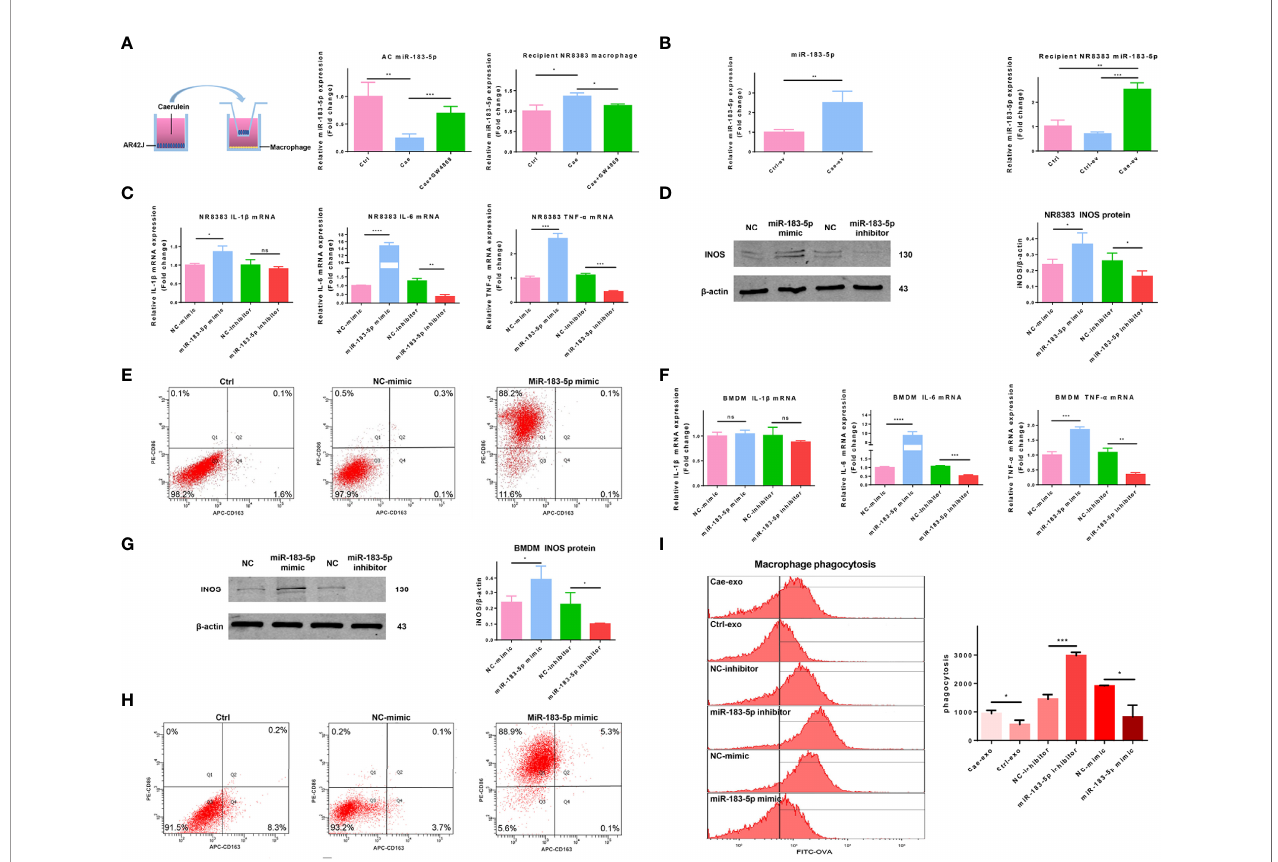
FIGURE 4 | AC-derived EV miR-183-5p promotes M1 macrophage polarization. (A) Expression of miR-183-5p in ACs and NR8383 macrophages from the Ctrl, Cae, or Cae+GW4869 group in a co-culture system. (B) Expression of miR-183-5p in NR8383 macrophages treated with Ctrl-ev or Cae-ev. (C) Levels of in fl ammatory cytokines (IL-1 b , IL-6 and TNF- a ) in NR8383 macrophages transfected with NC-mimic, miR-183-5p mimic, NC-inhibitor and miR-183-5p inhibitor. (D) Protein expression and analysis of iNOS in the aforementioned groups of NR8383 macrophages by western blotting. (E) The expression of CD86 and CD163 in the aforementioned groups of NR8383 cells was detected by fl ow cytometry. (F) Levels of in fl ammatory cytokines (IL-1 b , IL-6 and TNF- a ) in BMDMs transfected with NC-mimic, miR-183-5p mimic, NC-inhibitor and miR-183-5p inhibitor. (G) Protein expression and analysis of iNOS in the aforementioned groups of BMDMs by western blotting. (H) The expression of CD86 and CD163 in BMDMs transfected with NC-mimic and miR-183-5p mimic was detected using fl ow cytometry. (I) The phagocytic activity of macrophages in the Cae-ev, Ctrl-ev, miR-183-5p mimic and miR-183-5p inhibitor groups was quanti fi ed by fl ow cytometry. Data are presented as the mean ± SD. All experiments were repeated three times. * p <0.05, ** p <0.01, *** p <0.001. Ctrl: PBS-treated acinar cells, Cae: caerulein-treated acinar cells, Cae+GW4869: EVs from acinar cells co-treated with caerulein and GW4869, Ctrl-ev: EVs derived from PBS-treated acinar cells, Cae-ev: EVs derived from caerulein- treated acinar cells, NC-mimic: macrophages transfected with NC-mimic, miR-183-5p mimic: macrophages transfected with miR-183-5p mimic, NC-inhibitor: macrophages transfected with NC-inhibitor, miR-183-5p inhibitor: macrophages transfected with miR-183-5p inhibitor, and BMDMs: bone marrow-derived